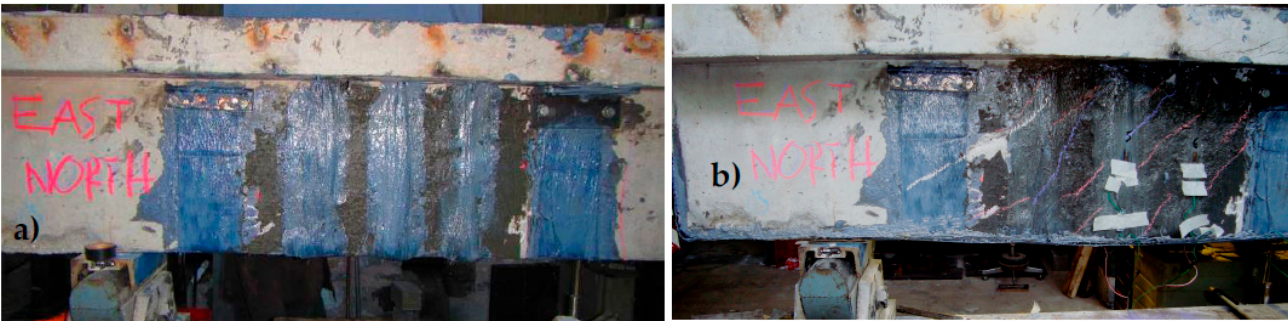
Figure 18. Comparison of the measured response between the Virgin RC prototype T-beam and this T-beam having been retrofitted with the 1st st rengthening scheme . ( a ) Shear force versus the deflection at mid-span. ( b ) Bending moment versus the deflection at mid-span.